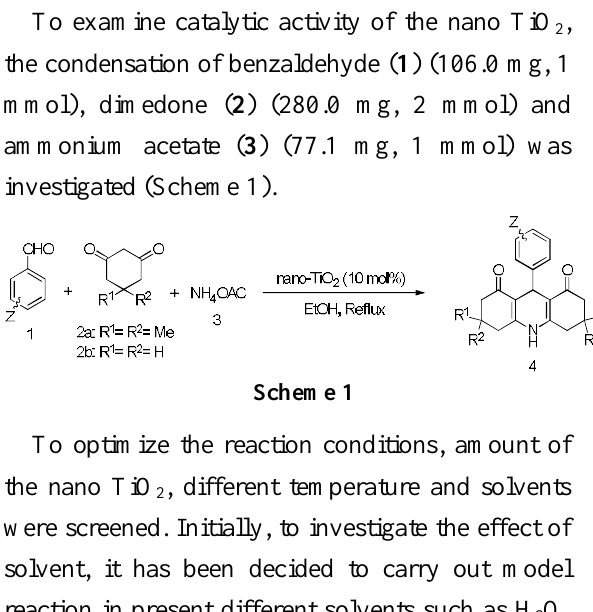
Fig. 4. TGA cure of the nano TiO